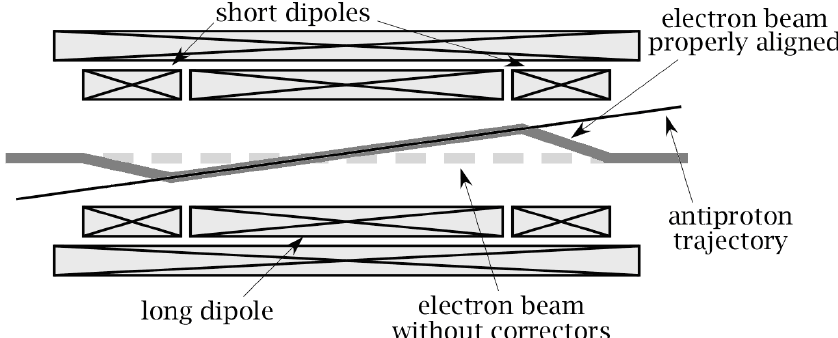
FIG. 4. Sketch of the placement and action of the dipole correctors (transverse scale exaggerated). Without activating the correctors, the electron beam would follow the dashed path in the main solenoid. By using the correctors, the electron beam can overlay the (anti) proton